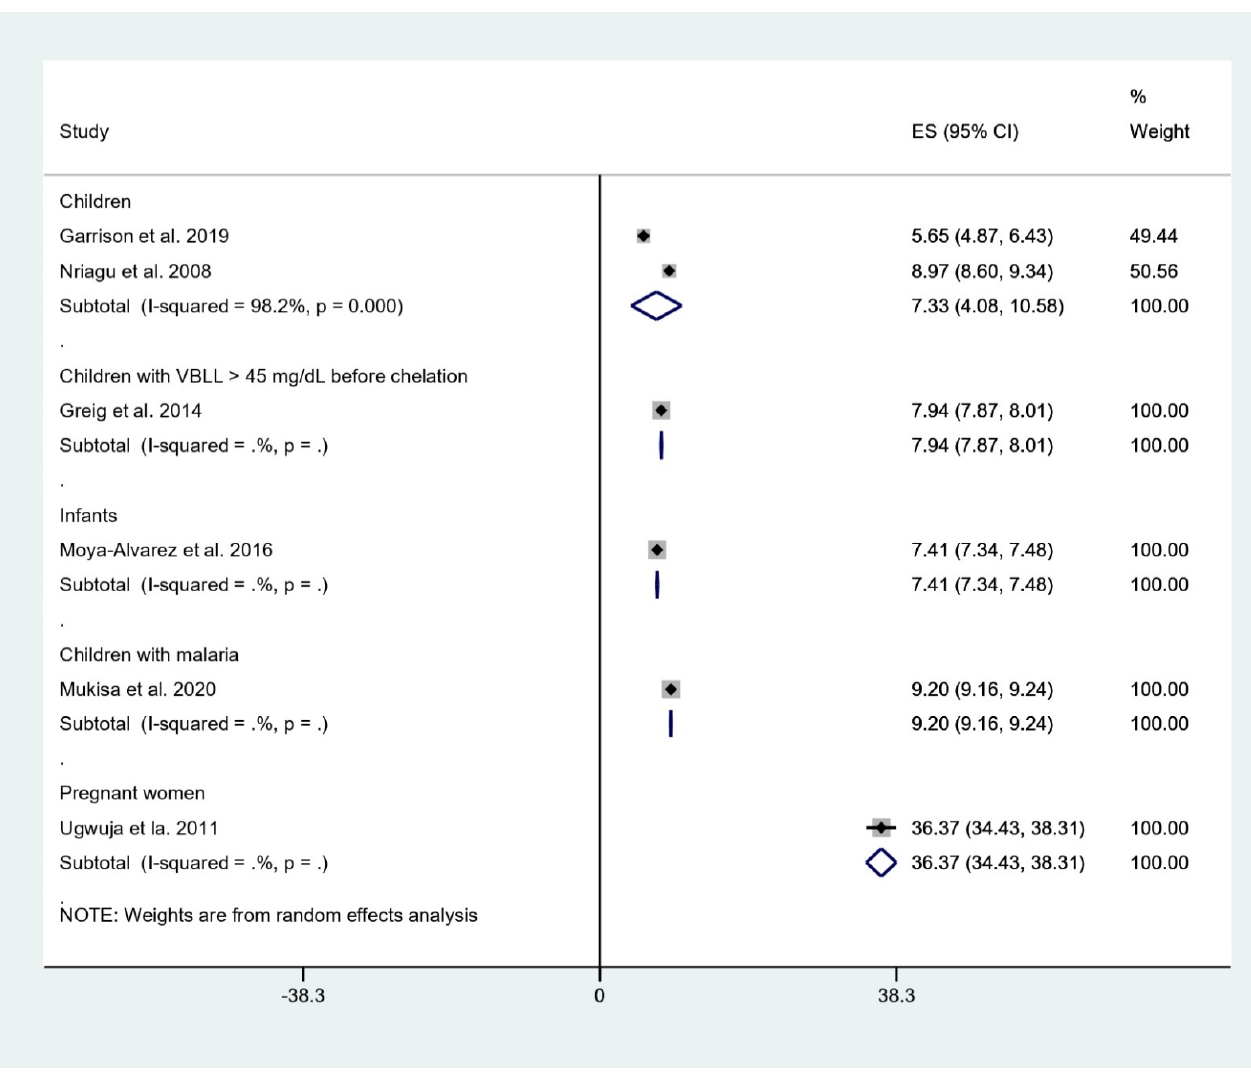
Figure 2. Mean BLL of participants. ES, effect size (mean BLL in µ g/dL); CI, confidence interval ( µ g/dL); black diamond symbol, point estimate; solid line in the middle of the graph at 0, zero effect size .